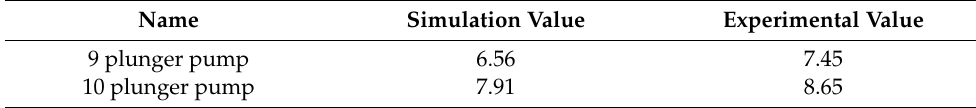
Figure 25. Experimental diagram of a 10-piston plunger pump. Table 3. Flow pulsation.